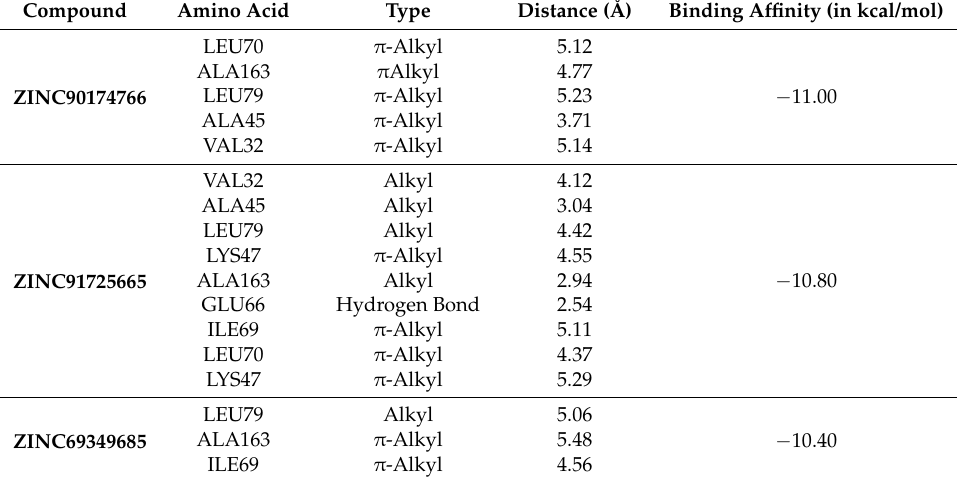
Table 4. Interactions between RIPK2 (from PDB ID 4C8B) and the following compounds are shown, after docking calculations: ZINC90174766 , ZINC91725665 , ZINC69431616 , ZINC12230819